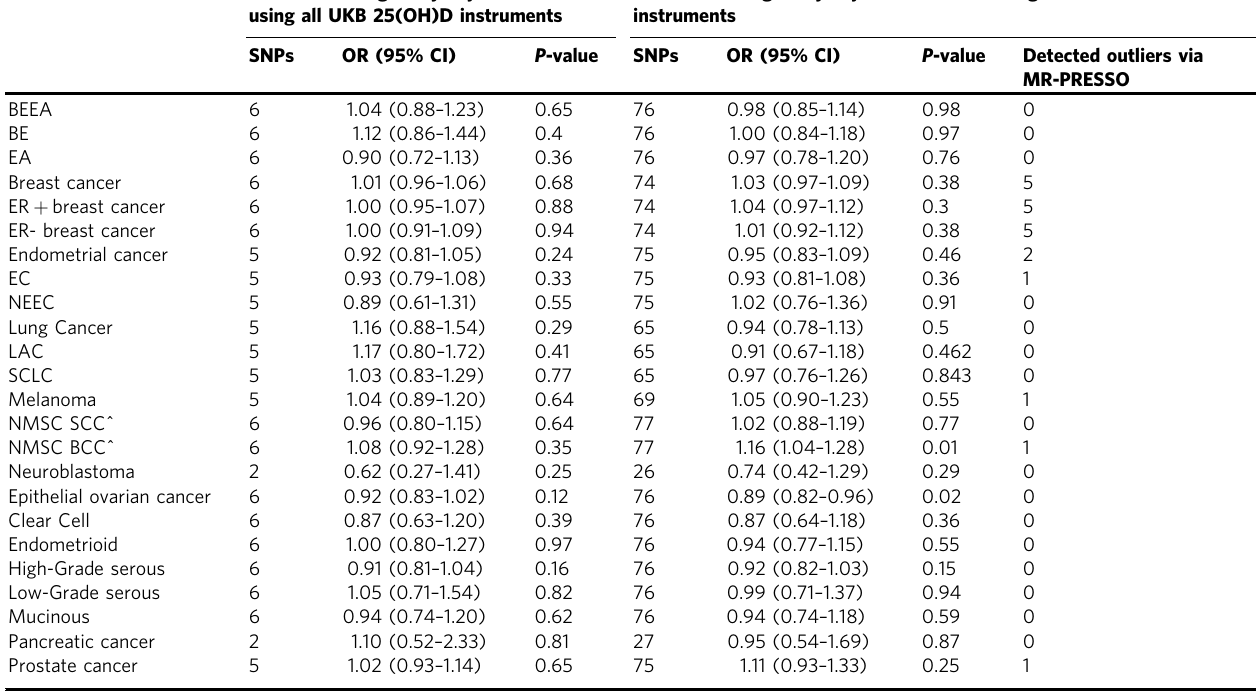
Table 2 Revised estimate for the association between one SD increase in genetically predicted serum 25(OH)D and cancer risk using UK Biobank 25(OH)D instruments.